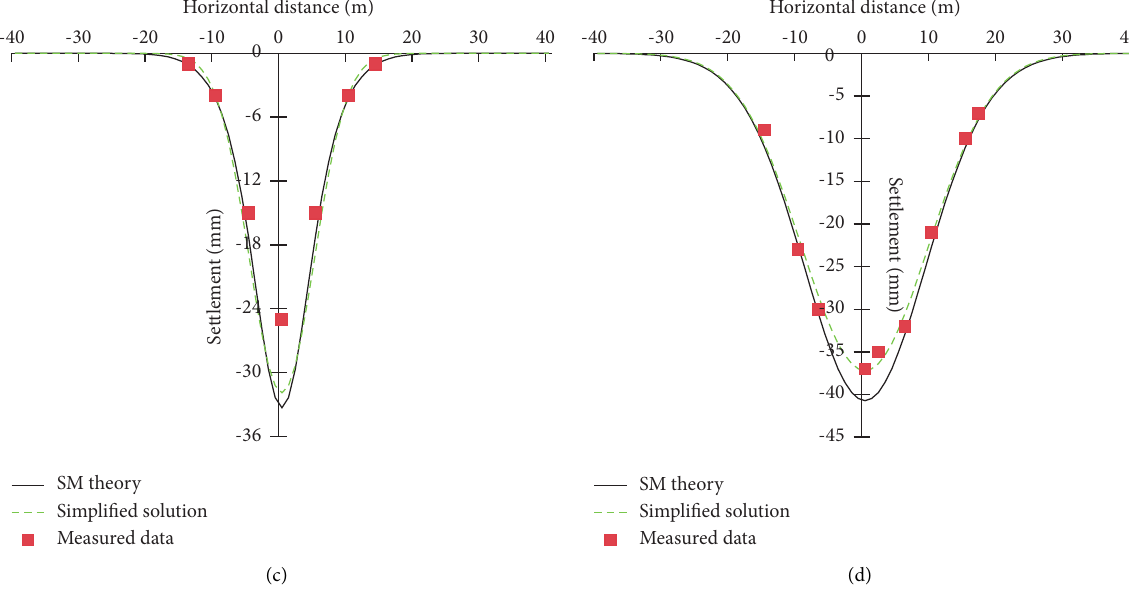
Figure 5: Measured and analytical ground surface settlement. (a) Urumqi City Metro Line 1 Tunnel in China; (b) Heathrow Express Trial Tunnel in London; (c) Barcelona Subway Tunnel in Spain; (d) Liu Yanghe Tunnel in China.